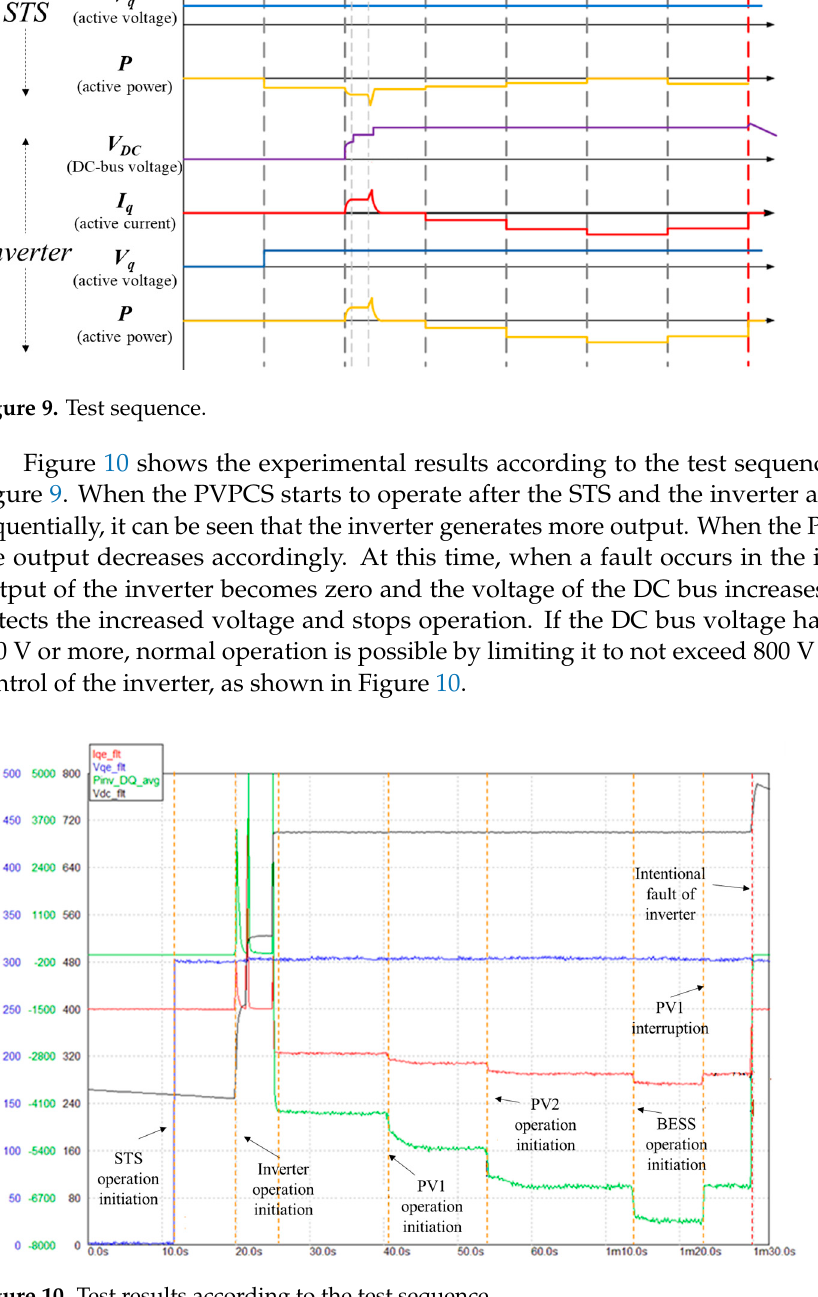
Figure 10. Test results according to the test sequence.